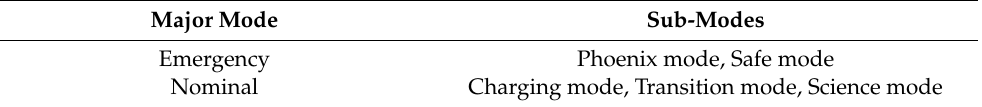
Table 6. IDEASSat operating